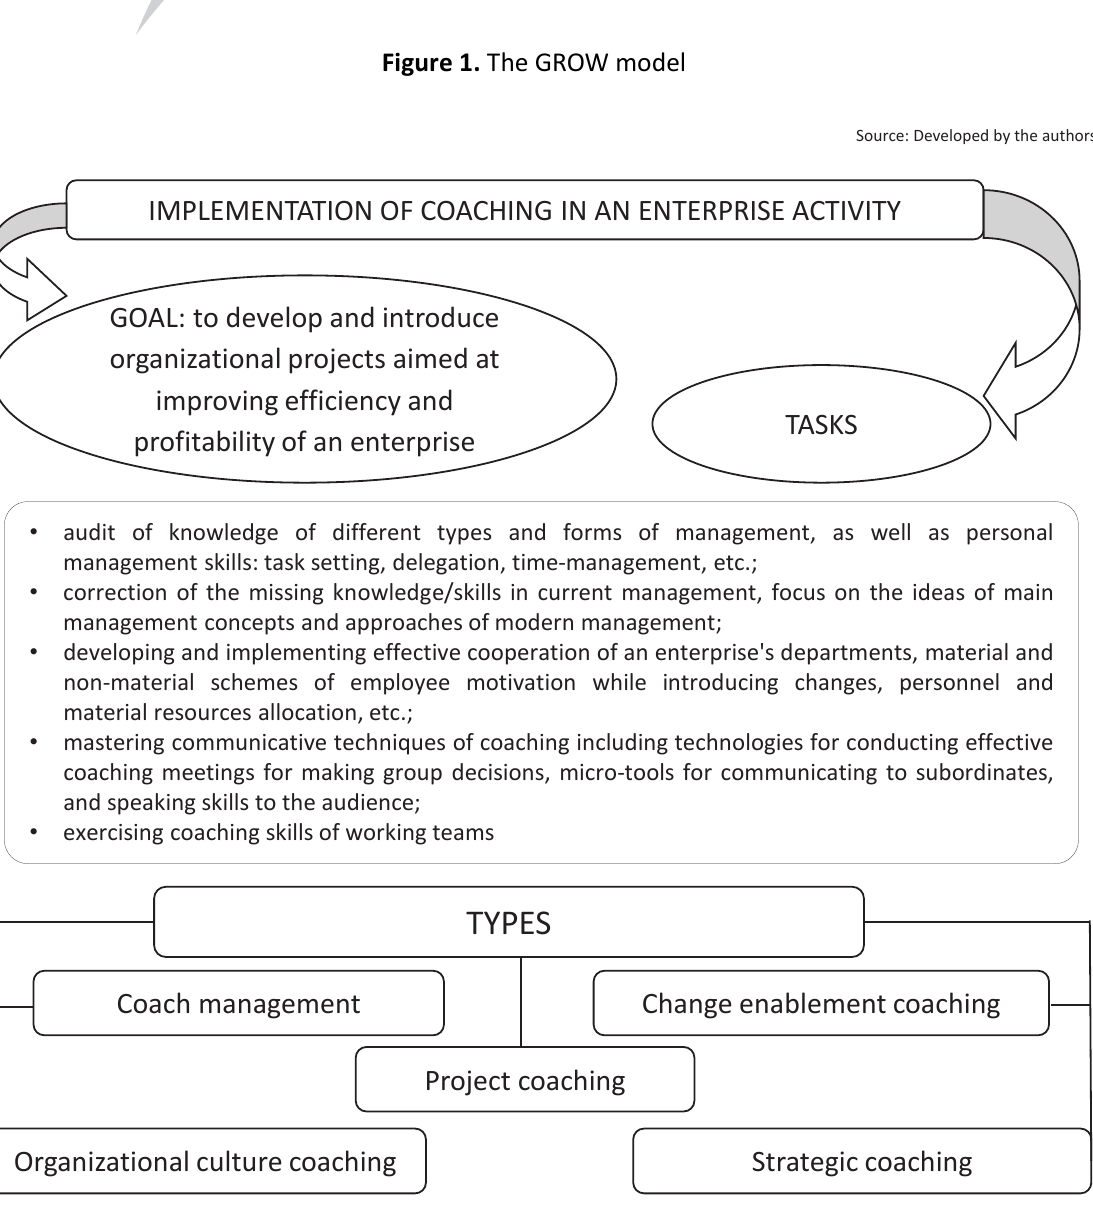
Figure 1. The GROW model